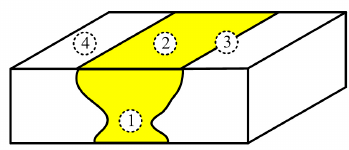
Figure 15. Schematic diagram of characteristic points of a welded joint for component analysis: ① root pass of the weld center; ② upper pass of the weld center; ③ boundary between the WZ and the HAZ; ④ HAZ.